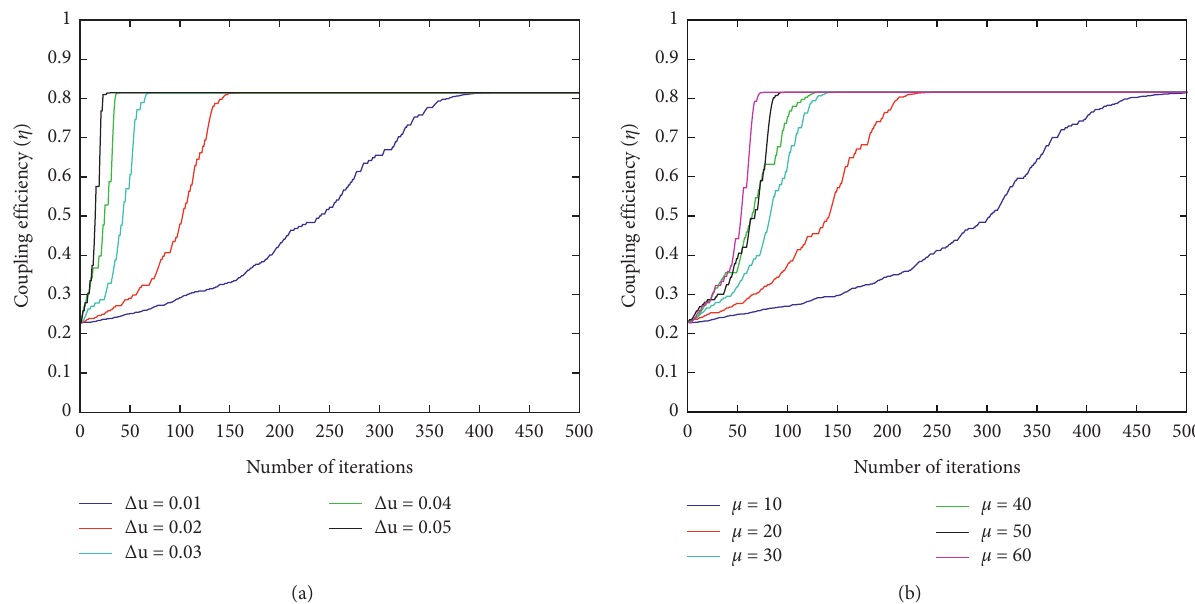
Figure 6: (a) Relationship between the coupling efficiency and the number of iterations under different disturbance voltages. (b) Re- lationship between the coupling efficiency and the number of iterations under different gain coefficients.